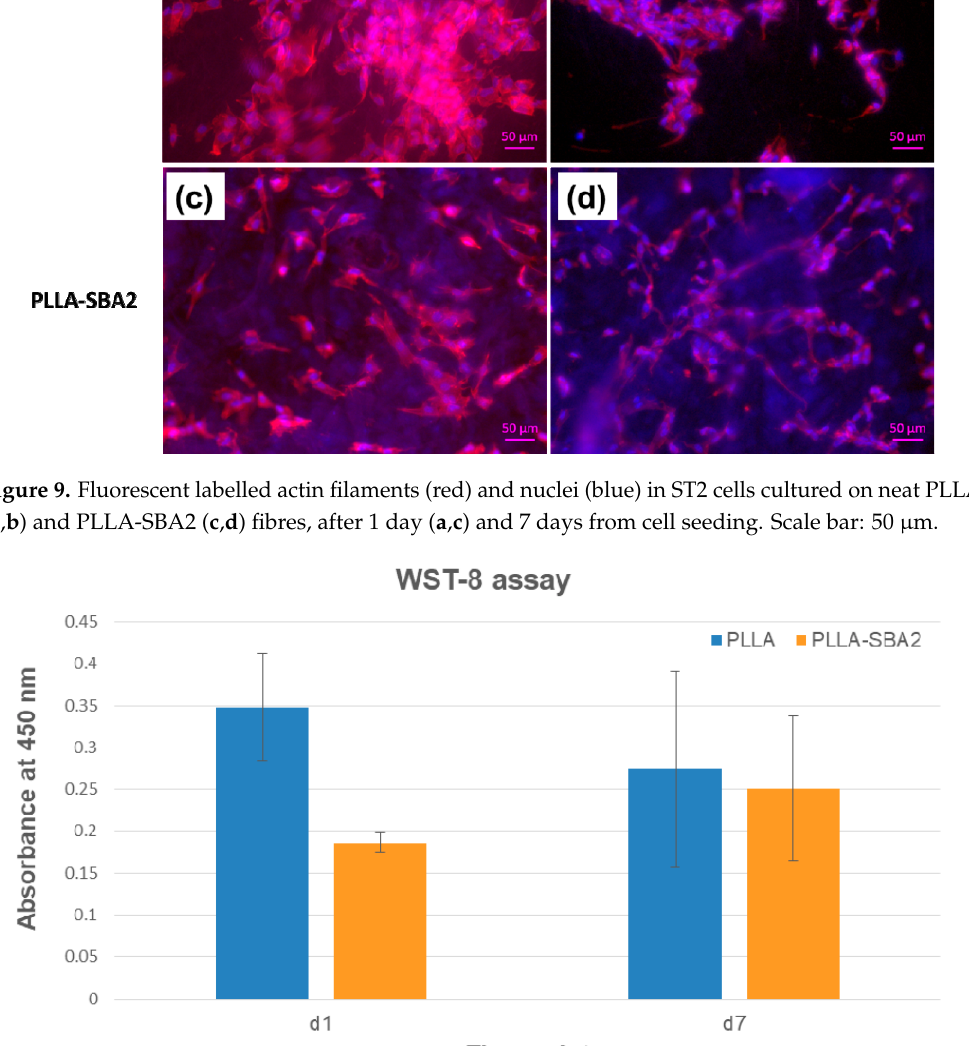
Figure 9. Fluorescent labelled actin filaments (red) and nuclei (blue) in ST2 cells cultured on neat PLLA ( a , b ) and PLLA-SBA2 ( c , d ) fibres, after 1 day ( a , c ) and 7 days from cell seeding. Scale bar: 50 µm.